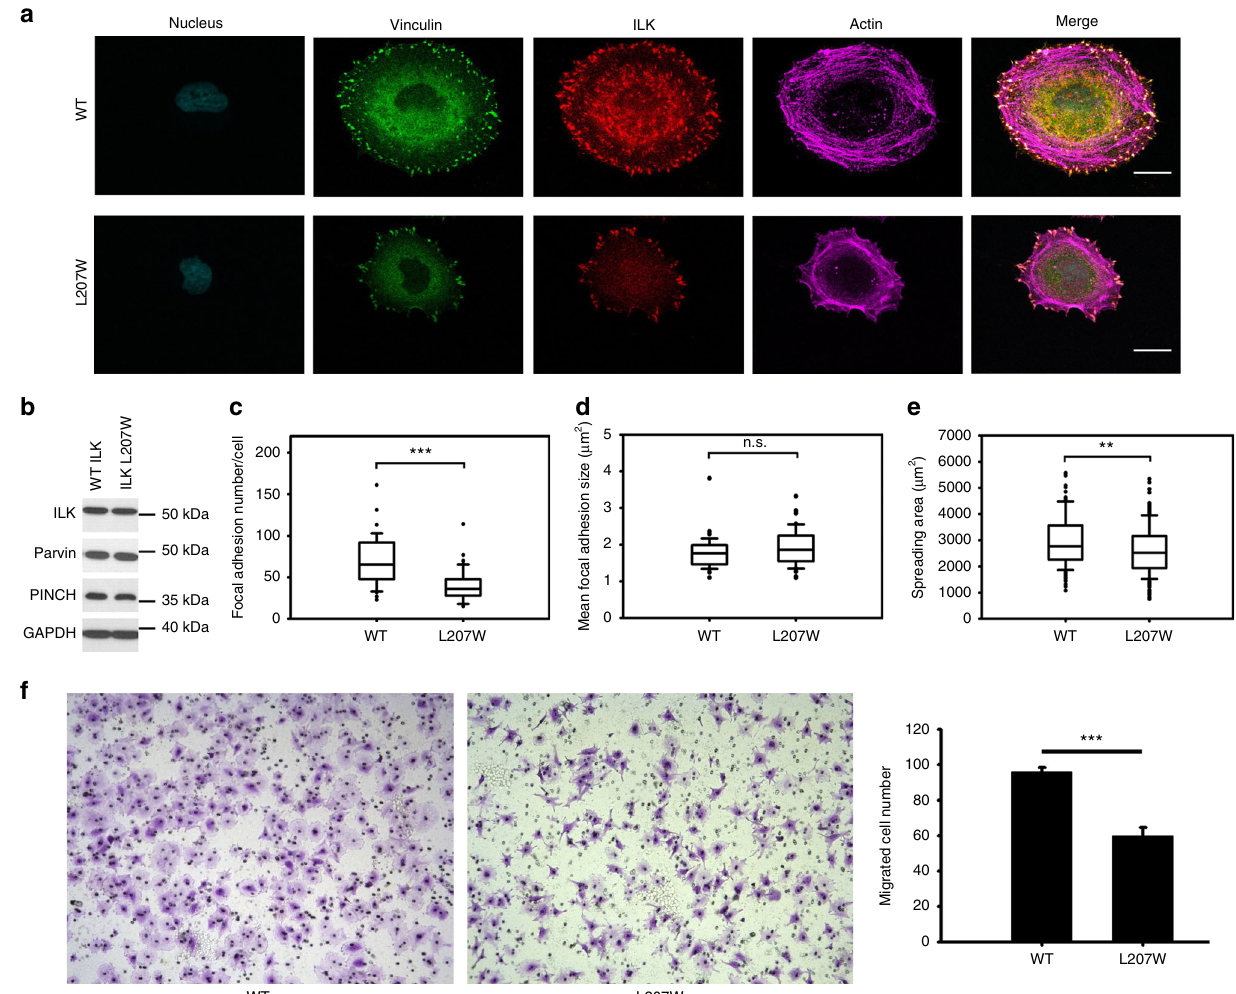
Fig. 8 Cellular defects by knock-in mutation (ILK L207W). a Comparison of focal adhesions and stress fi bers between WT ILK containing HeLa cells and ILK L207W knock-in cells. b Western blot of whole-cell lysates from CRISPR generated clones showing that ILK L207W had little effect on the expression of ILK, PINCH, and Parvin. c , d Quanti fi cation of focal adhesion number ( c ) and size ( d ) by WT ILK vs ILK L207W. e Cell spreading defects by ILK 207W. The box of the boxplot illustrated the upper and lower quartile for each population (WT ILK and ILK L207W). Median is marked by a horizontal line within the box. The attached whisker indicates the range, and the discrete points ( (cid:129) ) are the outliers. f WT ILK but not the L207W mutant in HeLa cells promotes cell migration signi fi cantly. Images were captured after 10 hours migration, under 10x magni fi cation (left and middle panels). Quantitative change of cell migration by WT ILK versus ILK L207W mutant (right panel). The migrated cell number was calculated from average of fi ve randomly picked fi elds for each insert. The results were obtained from three independent experiments. Values are given as mean ± S.E.M .Signi fi cance was calculated by t test